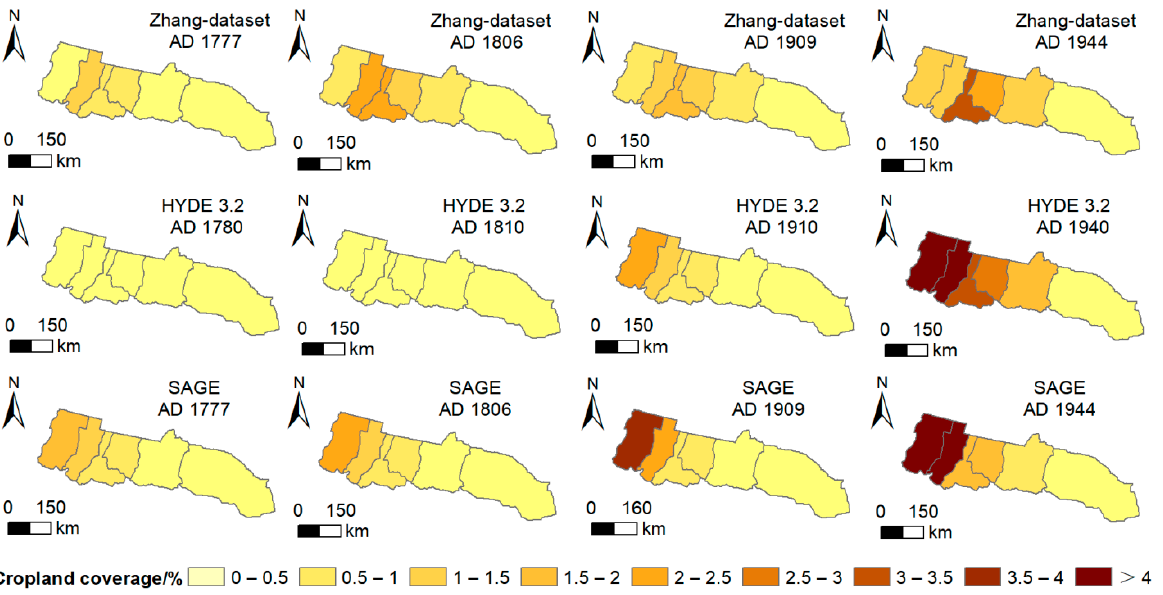
Figure 8. Comparison of changes in cropland coverage in the northern piedmont of the Tianshan Mountains between the Zhang dataset, HYDE 3.2, and SAGE for AD 1777, 1810, 1910, and 1944.